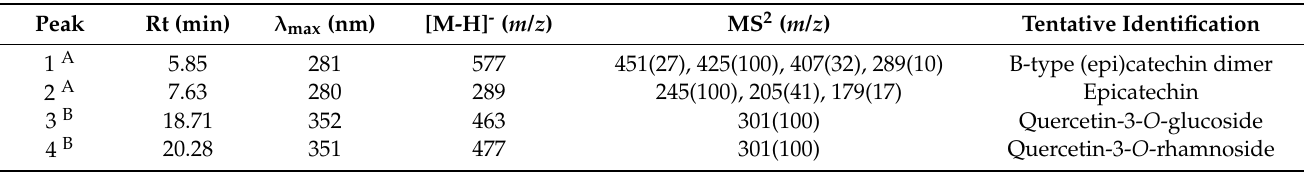
Table 1. Flavonoids composition of the kiwi peel extract. The retention time (Rt), wavelengths of maximum absorption in the visible region ( λ max ), and mass spectral data are